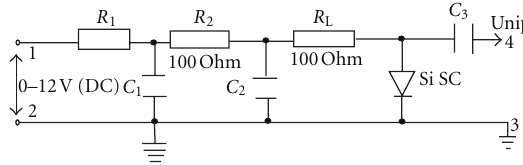
Figure 1: Circuit diagram of a solar cell